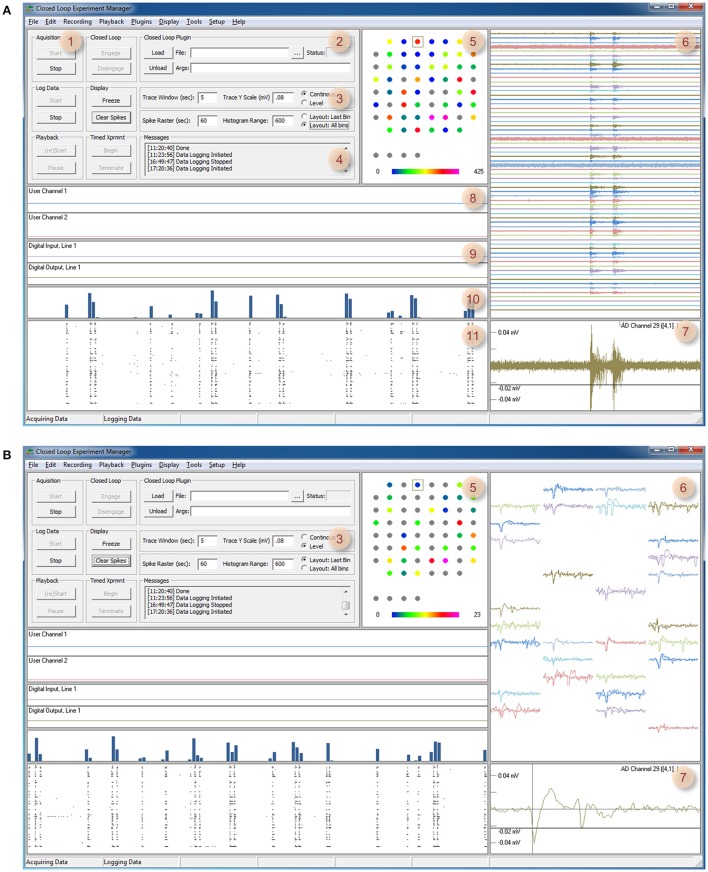
CLEM's Graphical user interface. (A) A screenshot of CLEMs main window (Continuous mode). The left top region contains readily accessible controls, whereas all other regions display incoming data and data statistics. (1) Controls for starting and stopping data acquisition, data logging, playback, and timed experiments. (2) Controls for loading and engaging closed loop “plugins.” (3) Controls for changing display modes and settings. (4) Text messages generated by CLEM and closed-loop functions. Double clicking on this window allows manual entry of ad-hoc comments. (5) Channel physical layout. Custom layouts can be created using any text editor and thereafter loaded from the Options menu. Cumulative spike rates are color coded according to color bar below. (6) Continuous voltage recordings from all channels. The time window and vertical scale are defined in region 3. (7) Magnified view of one channel. The particular channel is selected by double clicking on one of the traces or channels in regions 5 or 6. The threshold used for spike detection (black horizontal line) can be moved up and down interactively. (8) User data display—two channels of data generated by plugin functions can be displayed here. (9) Digital input and output, one line for each plot. IO lines to be displayed can be selected from the menu. (10) Histograms of spikes detected in all channels. (11) Rasters of spikes detected in all channels. The time window of regions 8–11 is defined using the controls in region 3. (B) A screenshot of the main window in Level mode. Here (6,7) waveforms of the most recent spikes detected in each channel (up to 10 most recent spikes) are displayed instead of continuous voltage values. Note also that region 5 shows momentary, rather than cumulative spike numbers (display mode controlled in region 3).